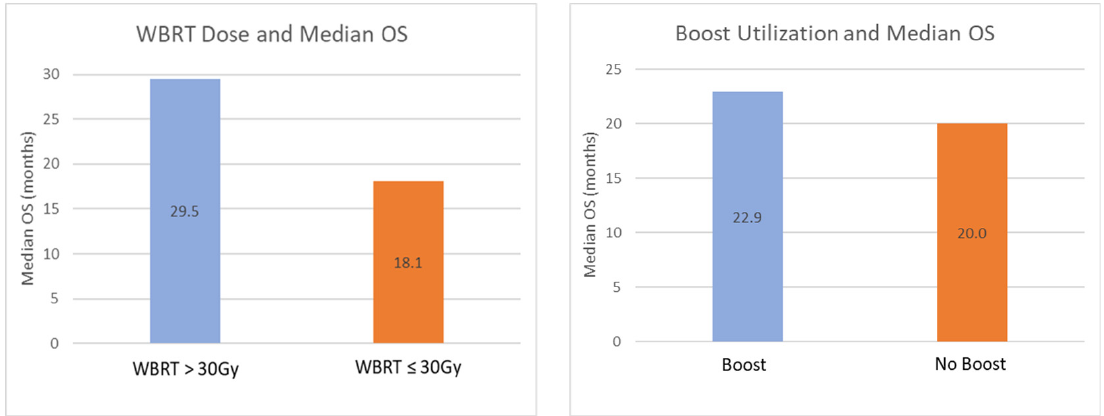
Figure 4. Median OS by WBRT dose ( Left ), and the implementation of a boost to gross disease ( Right ). WBRT dose >30 Gy was associated with marked increase in median OS = overall